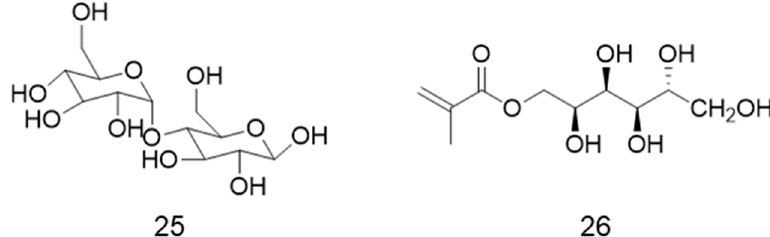
Figure 13. Chemical structure of maltose ( 25 ) and sorbitol methacrylate ( 26 ) used for the synthesis of polymer brushes by RDRP.